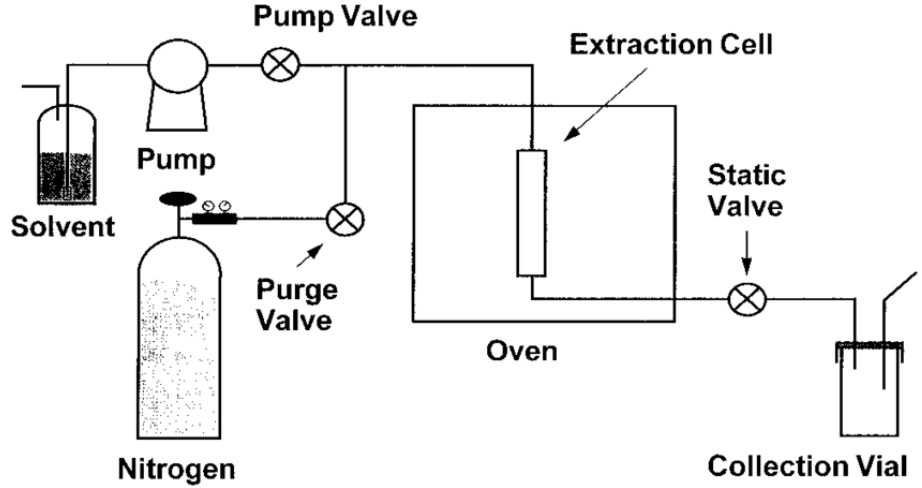
Figure 4. Schematic diagram of an accelerated solvent extraction (ASE) system [40].